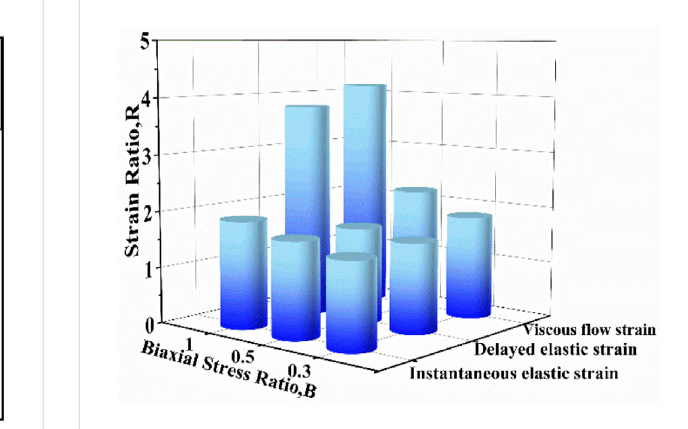
FIGURE 11 The strain ratio as a function of biaxial stress ratio for instantaneous elastic strain, delayed elastic strain and viscous fl ow